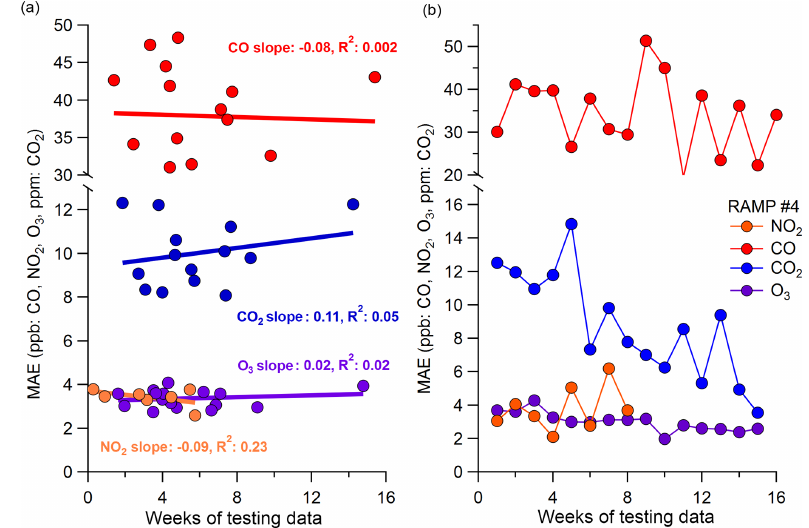
Figure 8. (a) Mean absolute error (MAE) versus the length of the testing period for CO (red), CO 2 (blue), NO 2 (orange), and O 3 (purple) for all the RAMP monitors. (b) Changes in MAE over time for the RAMP monitor with the longest testing window (RAMP #4). The figure shows that the MAE is generally unchanged (or in some cases improves) as the amount of testing data increases, suggesting the RF models are stable over the study